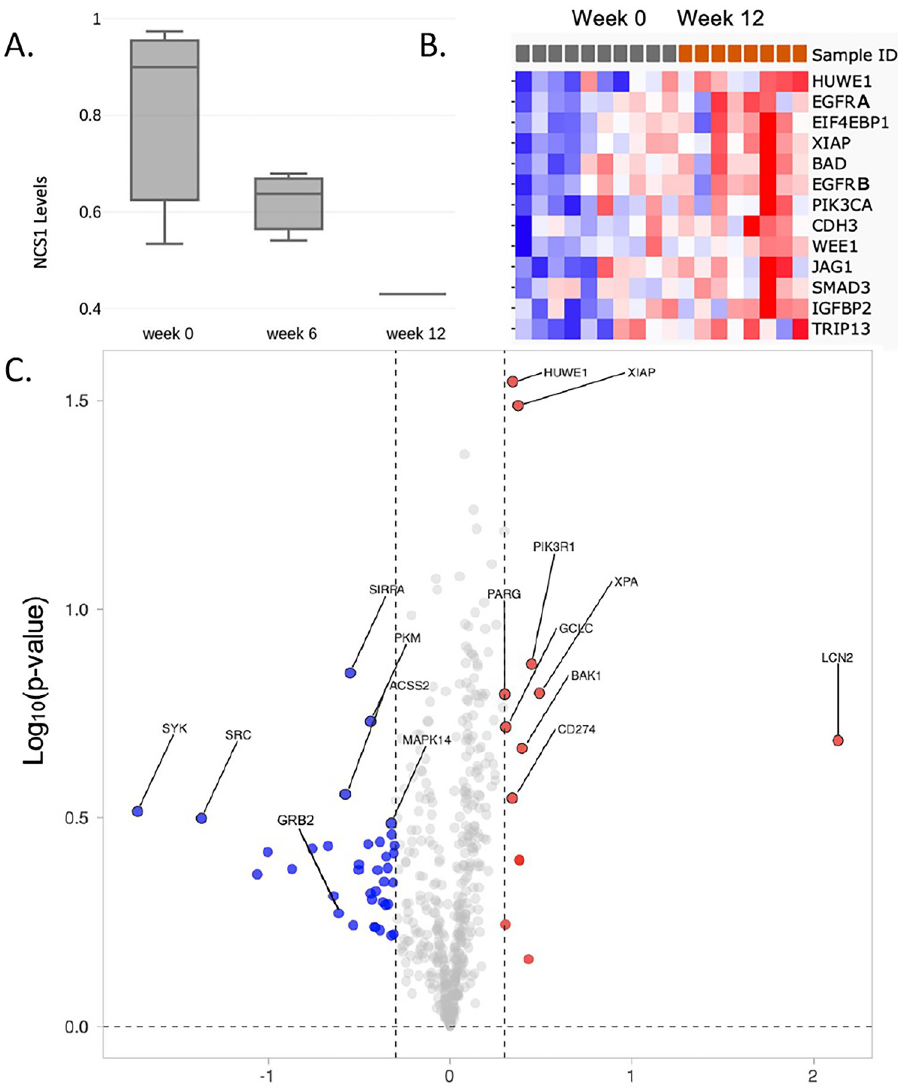
Fig 4. Measurement of protein expression. A. NCS1 levels over the course of 12 weeks of treatment. Western blot assessment of NCS1, using beta-actin as a loading control, in samples from patient white blood cells (n = 3 for weeks 0 and 6). Only one blood cell sample was available for assessment at week 12. The individual values for NCS1 (using beta-actin as a loading control) are: Baseline—0.97, 0.53, 0.90; week 6–0.67, 0.54, 0.63; week 12–0.43 B. Heatmap with proteins which had a 35% or greater increase in expression from the start of treatment (week 0) to completion (week 12). Sample ID refers to individual patients (n = 10). In the top line, gray boxes are baseline values, orange boxes are values after 12 weeks of treatment. Refer to Table 2 and panel C for further information. The progression from blue to red indicates that the protein levels go up relative to their baseline values. EGFR is listed twice (EGFRA and EGFRB) because two different EGFR related antibodies were included in the RPPA core tests. C. Volcano plot showing changes in protein levels as assessed by the MD Anderson Cancer Center RPPA Core using patient white blood cell samples (n = 10). Blue dots represent proteins which had an overall decrease, and red dots represent proteins which had an overall increase. Normalized protein levels were mean centered and a threshold of log2 (Fold Change) of (-.35,.35) was used (dashed line). No significance threshold is depicted in the graph, but the further up a protein is on the y-axis, the more significant of a change. P-values were not adjusted.